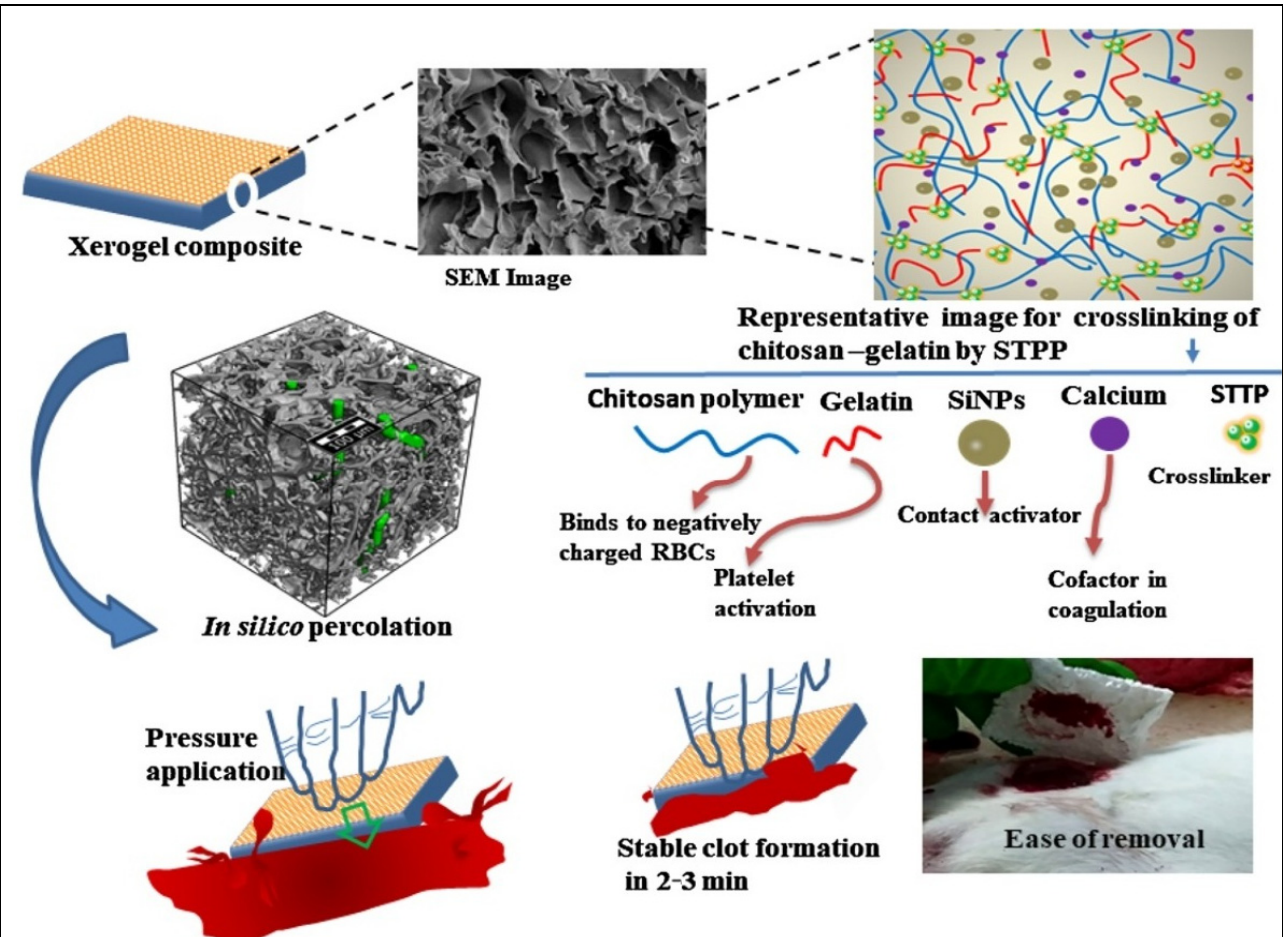
Figure 4. Chitosan-gelatin xerogel composite loaded with silica nanoparticles and calcium for rapid halting blood loss, showing the interaction between the biopolymers and its wound healing properties. Adapted from Patil et al. [14], with permission from Elsevier 2022.